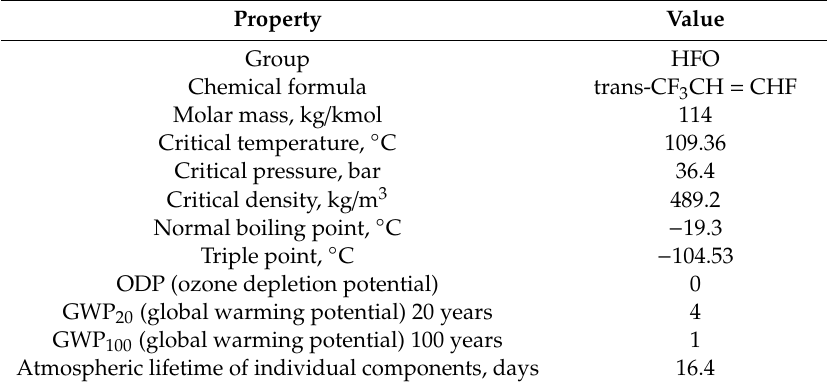
Table 1. Basic properties of the R1234ze(E) refrigerant